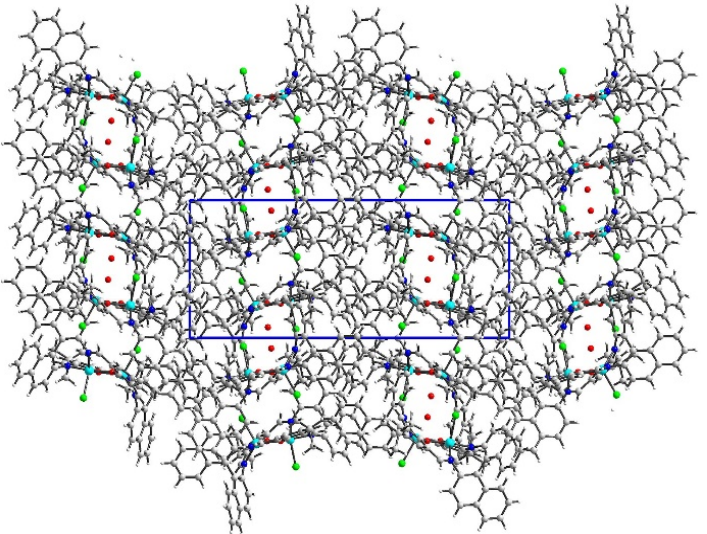
Figure 5. The crystal network of K2 showing channels running along the b axis filled with water molecules. The unit cell is given in blue box. Table 1. Selected bond length (Å) and valence angles ( ◦ ) for the complex K1